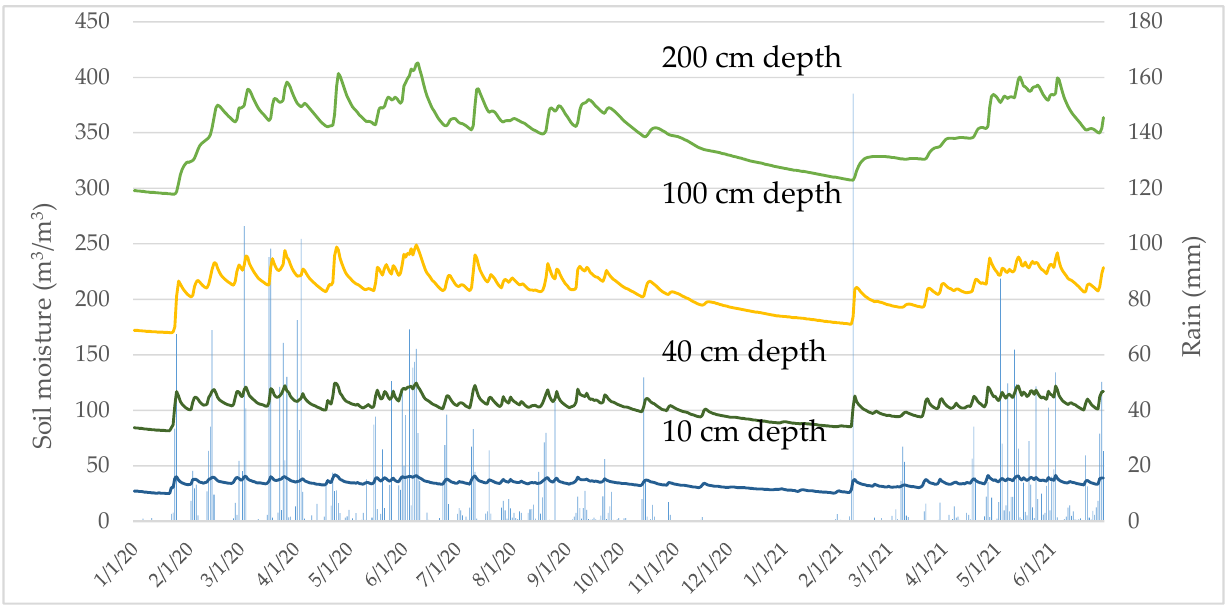
Figure 6. Average daily soil moisture of 10 locations at different soil depths vs. rainfall in 1.5 years. The fluctuations of the river flow and soil water content in response to the precipitation combined is presented for Guilin in the below graph (Figure 7). As can be seen, during the first 4 months of the year, since the soil water content is low, the major portion of the precipitations is percolated into the karstic network rather than causing any considerable raise in the river flow. In the following 3 months however, the river flow magnitude rose only after the ARCK reached its full